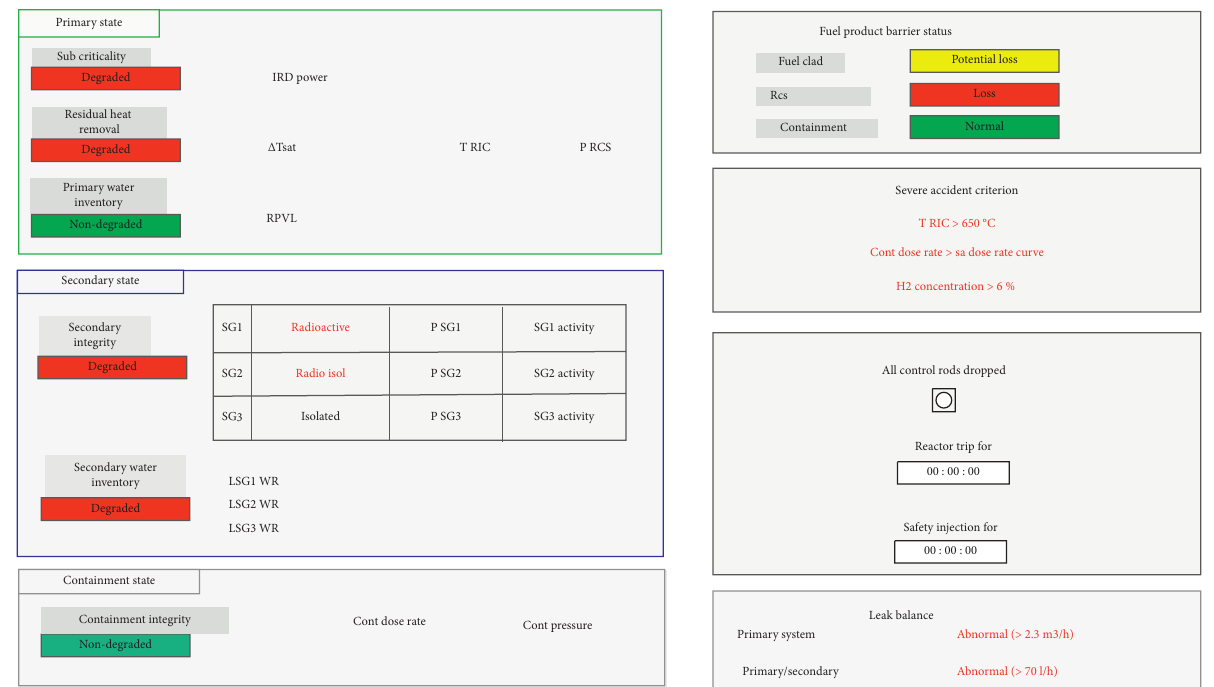
Figure 7: Monitoring